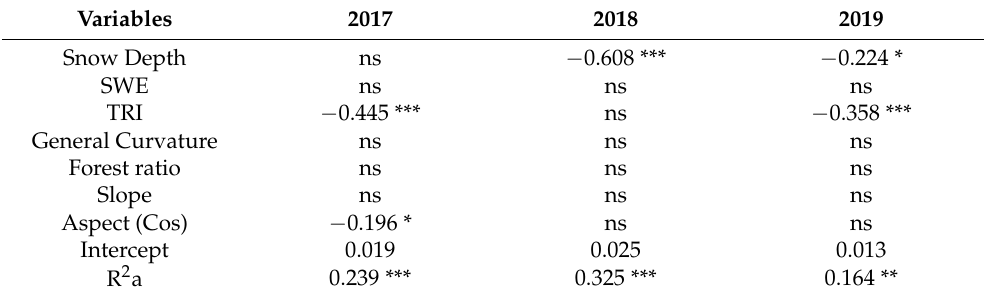
Table 4. Adjusted R 2 , slopes, and intercepts for computed regression equations describing H 2 vs. land cover and topography predictors relationships (ns = predictor variable not selected).